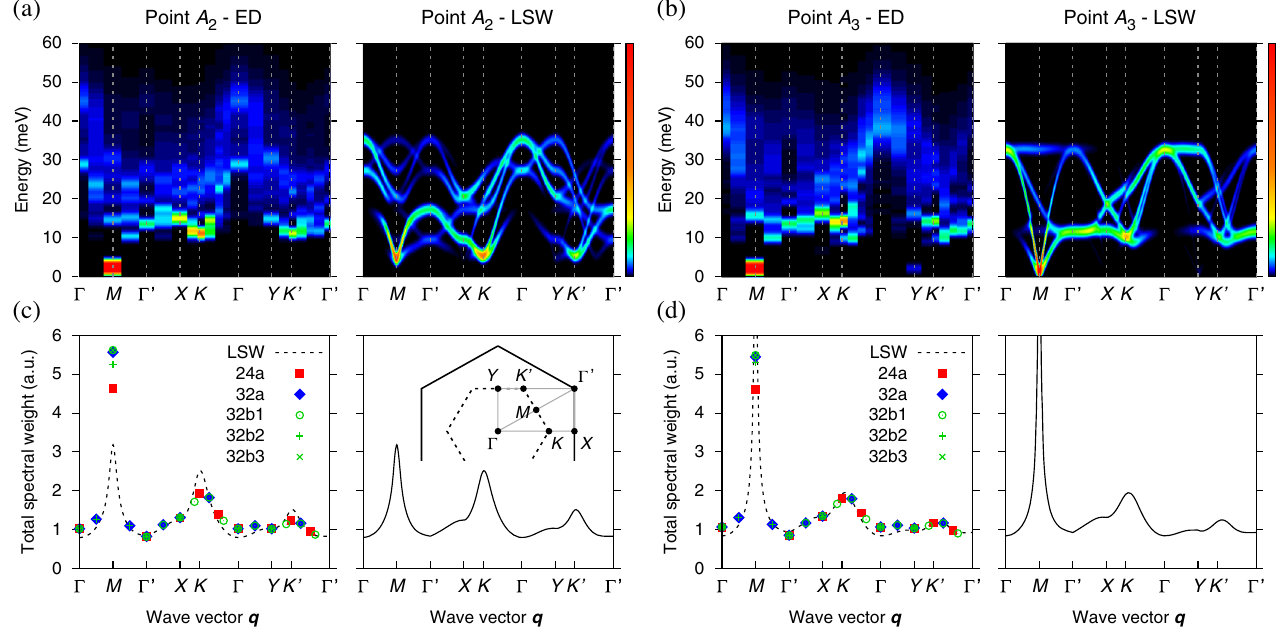
FIG. 5. (a) RIXS intensity maps for the parameter point A 2 and the same energy scale as in Fig. 4(b). The left and right are obtained by exact diagonalization and the linear spin-wave approach, respectively. To better resolve the finer features, Gaussian broadening with a small FWHM of only 2 meV is used in both cases. In the case of LSW, the spectra are averaged by equally employing all three possible zigzag pattern directions. This procedure leads to a map that could be directly compared to the ED one, since the cluster ground state used in ED contains all zigzag pattern in an equal-weight superposition. (b) The same for the parameter point A 3 and the energy scale as in Fig. 4(c). (c) Energy-integrated RIXS response (total spectral weight) corresponding to (a). Data for all the clusters are presented, showing negligible finite-size effects on the spectral weight. The curve obtained by the linear spin-wave approach (right) is shown also on the left by a dashed line. (d) Total spectral weight for the data in